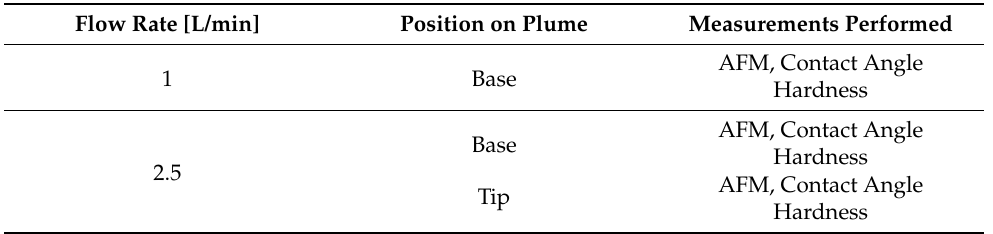
Table 1. Summary of the measurements performed on the UHMWPE surface after the different plasma treatments.